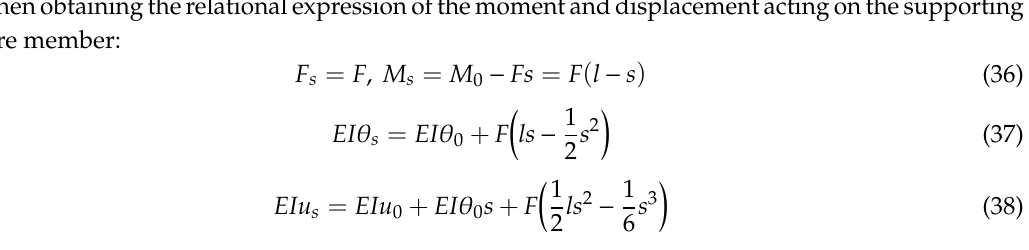
Figure 14. Schematic diagram of simplified wind turbine system.